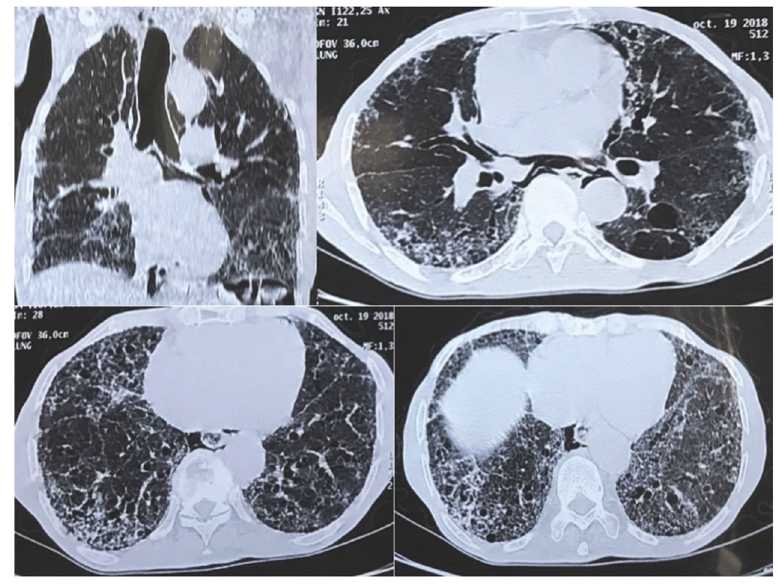
Figure 3: CT scan showing bronchiectasis, bullous emphysema, and fibrosis.